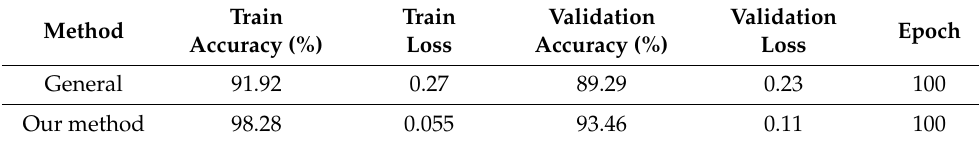
Table 3. Data augmentation method